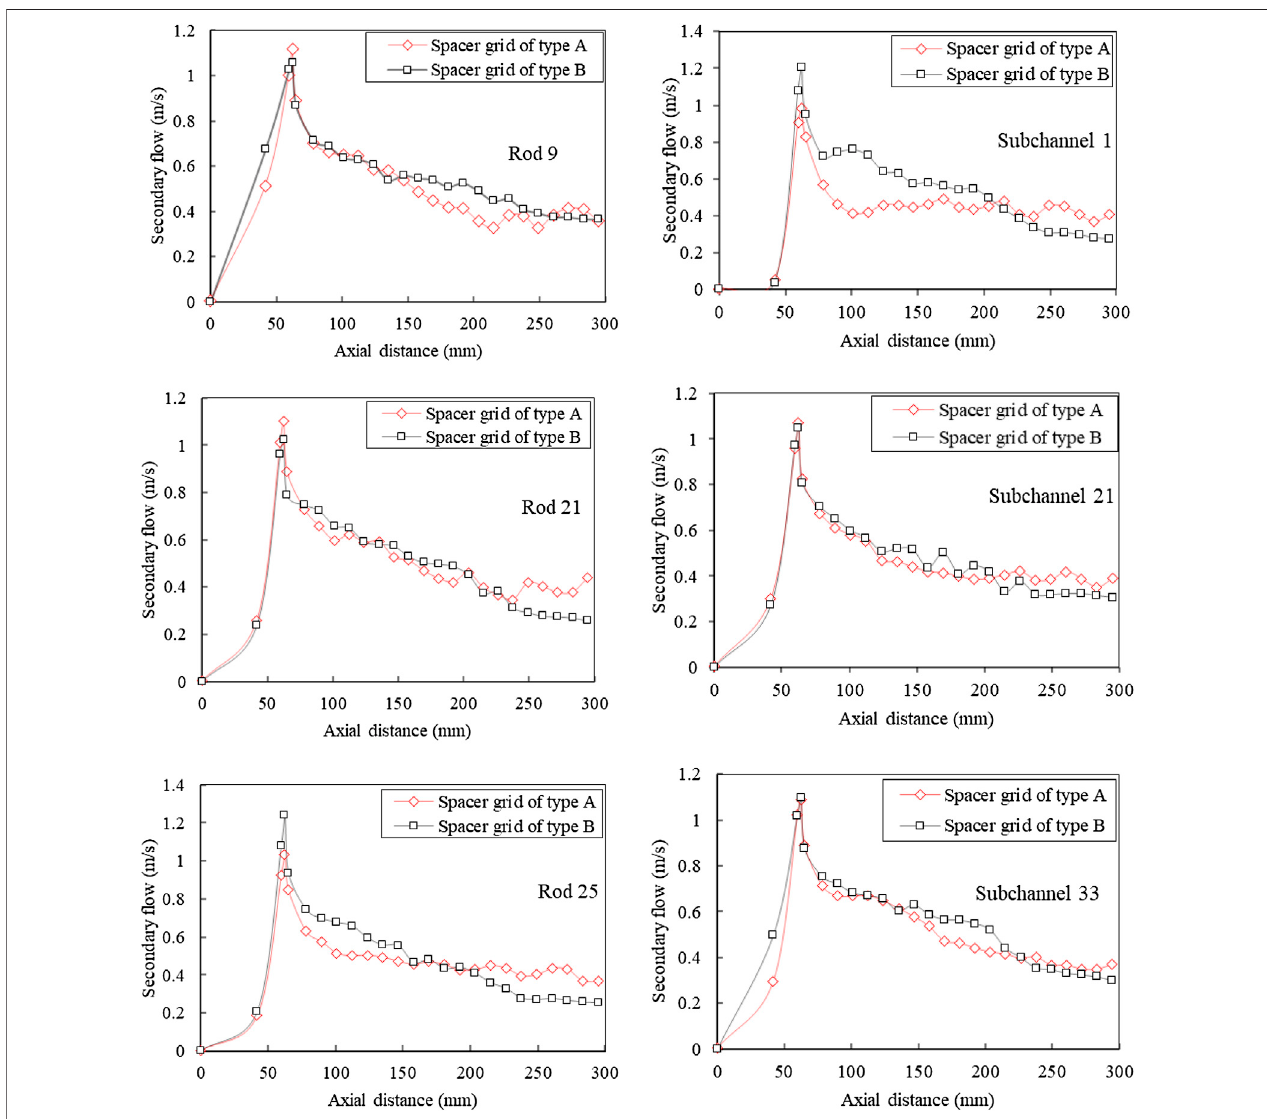
FIGURE 10 | Distribution of secondary fl ow along axial direction in the sub-channel and around the fuel rod.